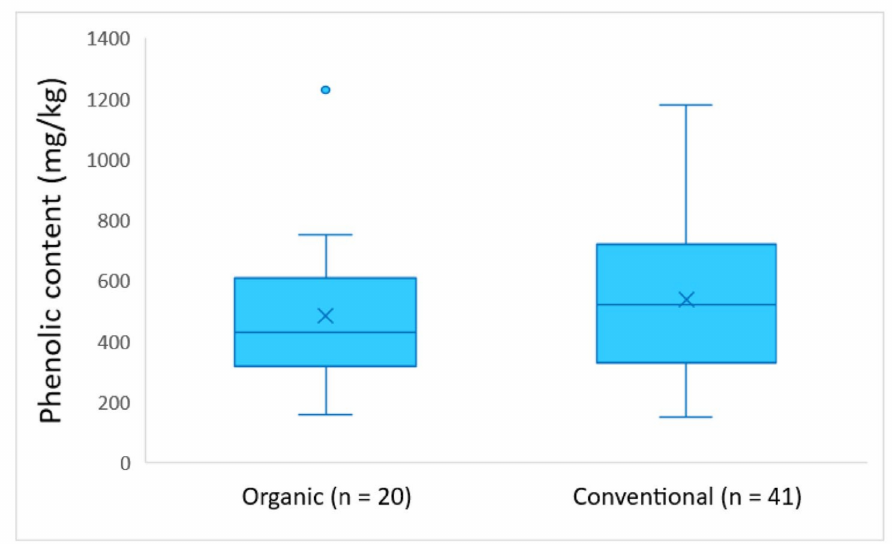
Figure 6. Phenolic content of the analyzed EVOOs produced in 2017–2018 in comparison with the farming type (organic or